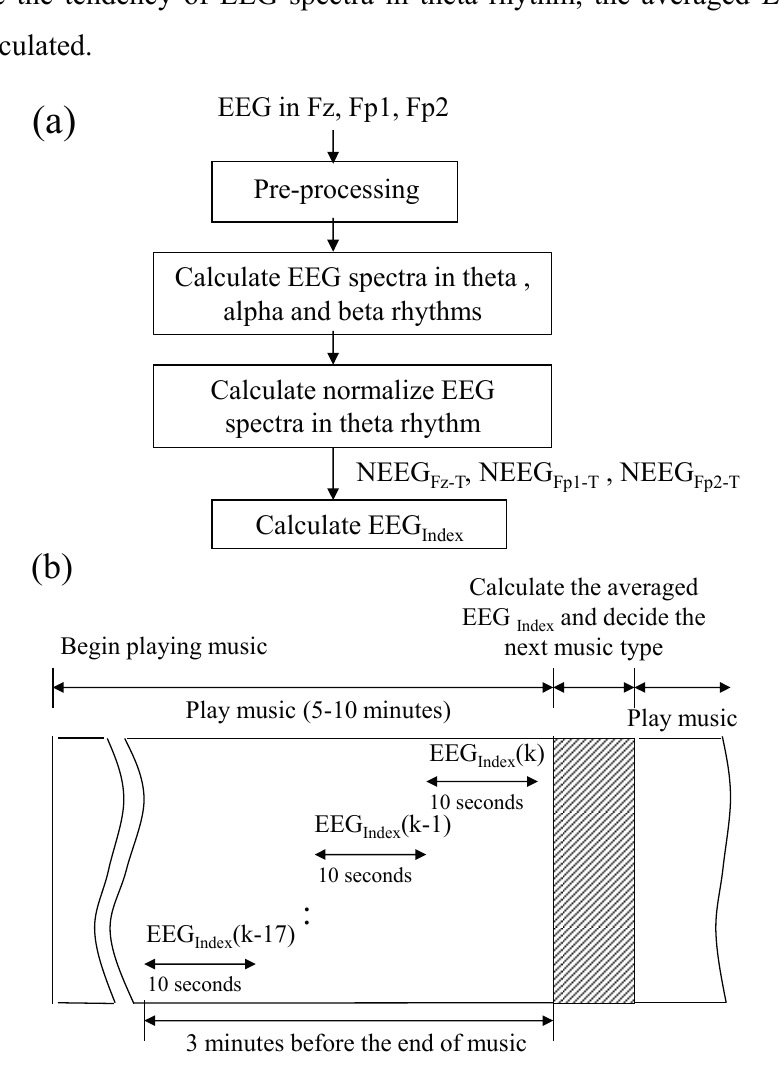
Figure 4. ( a ) Flowchart of EEG feature extraction algorithm, and ( b ) time-series diagram of multimedia